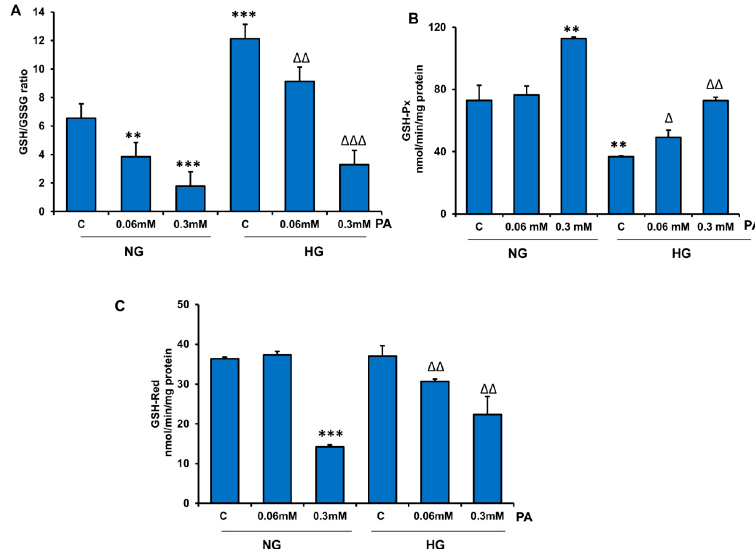
Figure 5. Effect of high glucose/high palmitic acid (HG/HPA) on glutathione (GSH) metabolism. HepG2 cells were treated with different doses of palmitic acid under normal and high glucose conditions. GSH/GSSG (reduced/oxidized glutathione) ratio ( A ), GSH-Px (glutathione peroxidase) ( B ), and GSH reductase (glutathione reductase) ( C ) were measured. Results are expressed as mean +/ − SEM of three experiments. Asterisks indicate significant differences (** p ≤ 0.005, *** p ≤ 0.001) relative to untreated control cells under normal glucose condition (NG-C), triangles indicate significant differences ( Δ p ≤ 0.05, ΔΔ p ≤ 0.005, ΔΔΔ p ≤ 0.001) relative to untreated control cells under high glucose condition (HG-C).